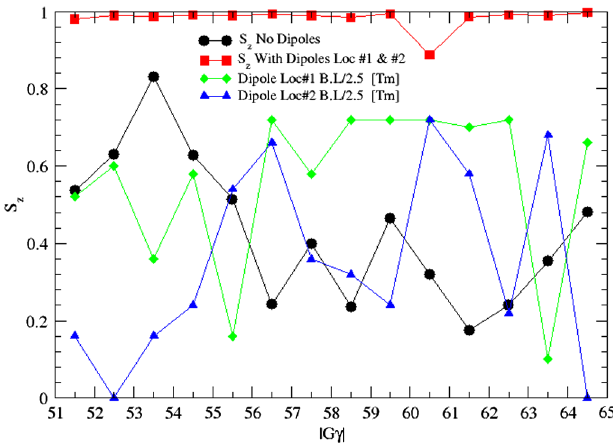
FIG. 8. The stable spin direction (red squares) at the exit of the AtR line as a function of half integer j G γ j values when both sets of dipoles at the locations ♯ 1 and ♯ 2 , (green and red rectangles shown in Fig. 2) are excited. The black circles correspond to the S values when both sets of the three dipoles z at the locations ♯ 1 and ♯ 2 shown in Fig. 2 are set to zero. The green diamonds and the blue triangles are the values of the R B · d l = 2 . 5 for the dipoles at the locations integrated dipole field ♯ 1 and ♯ 2